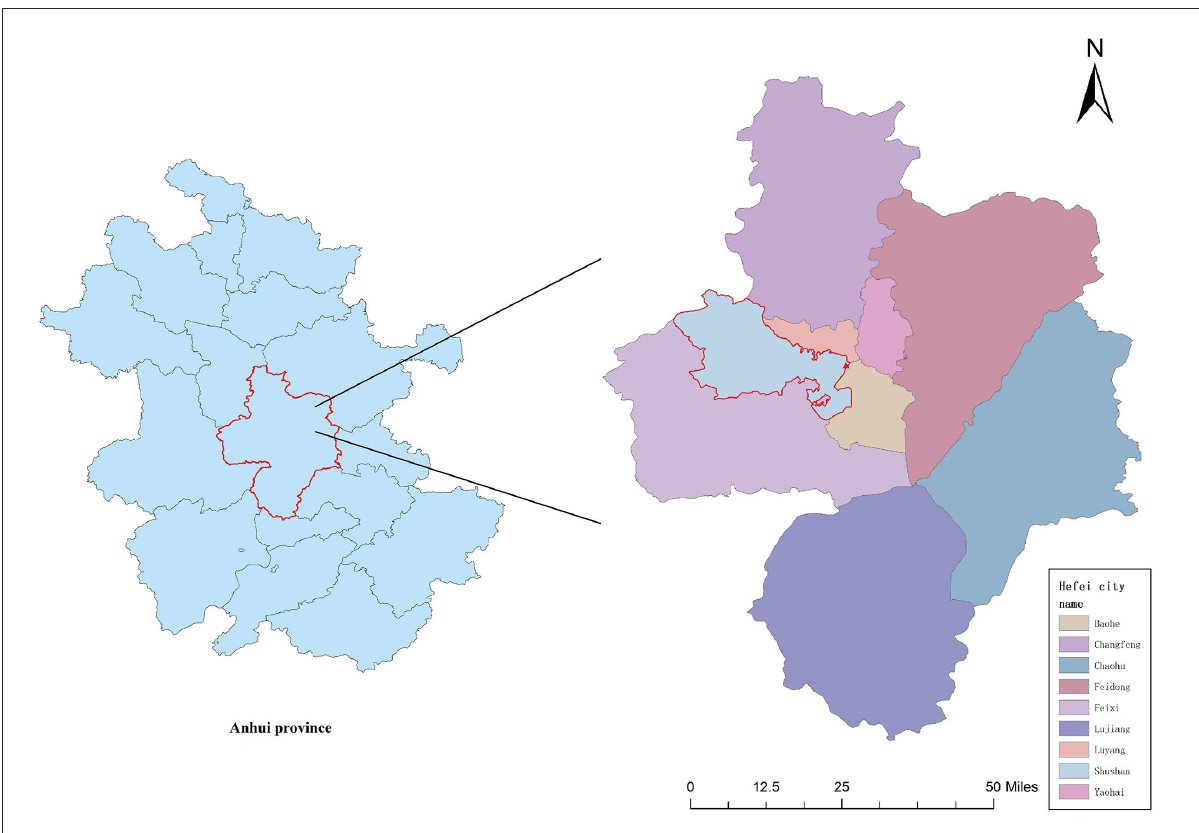
FIGURE1 A map of the sample city and hospital (the city circled in red is Hefei, the city we studied, and the triangle represents the location of the